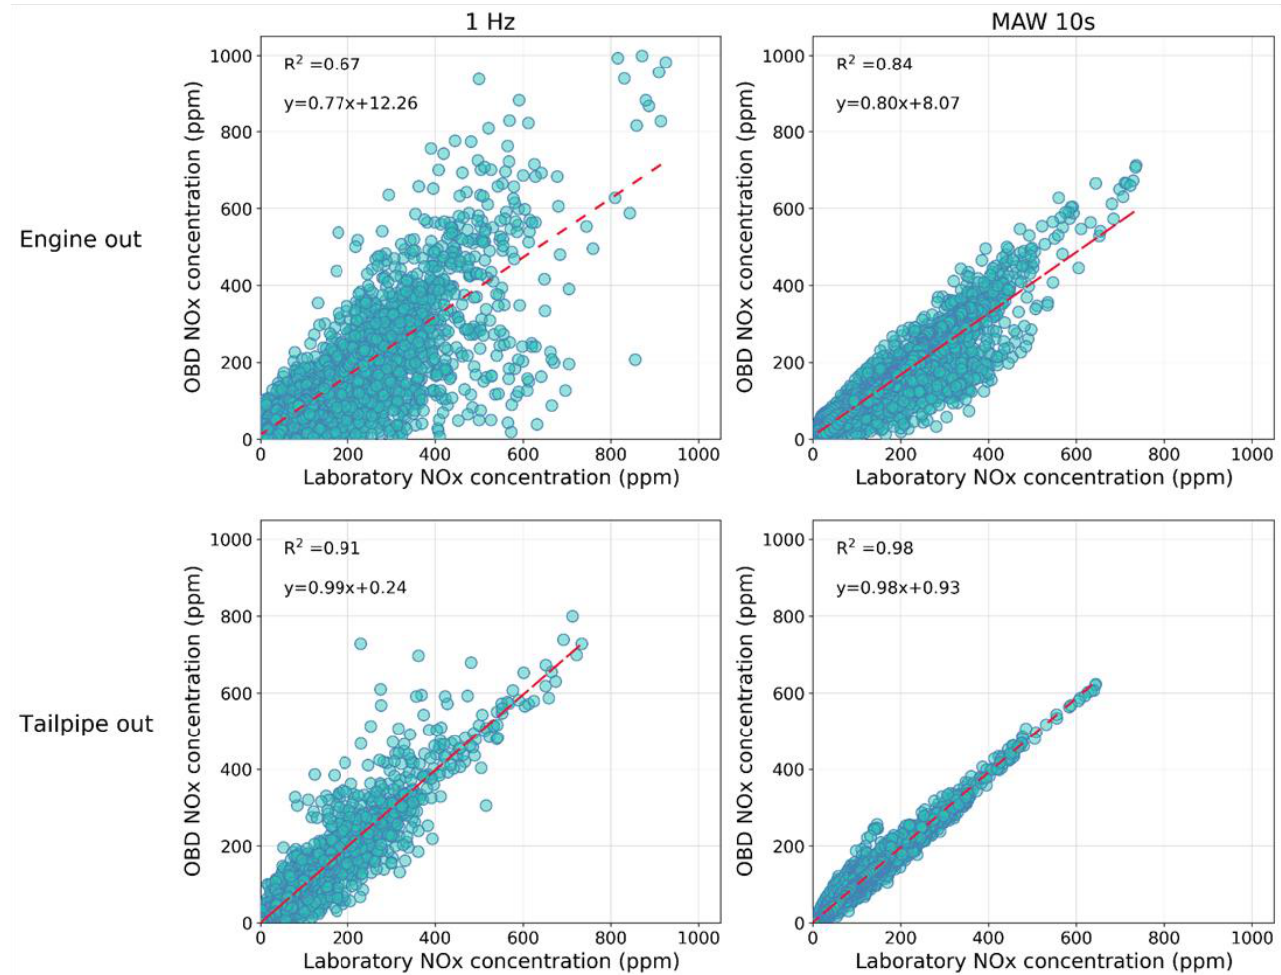
Figure 4. Plots showing the correlation between OBD signals and 1 Hz laboratory measurements at the engine-out (top graphs) and tailpipe-out (bottom graphs) of Vehicle 1. Different correlation methods are compared: 1 Hz data in the left-hand-side panels and a 10 s moving average window (MAW) in the right-hand-side panels.